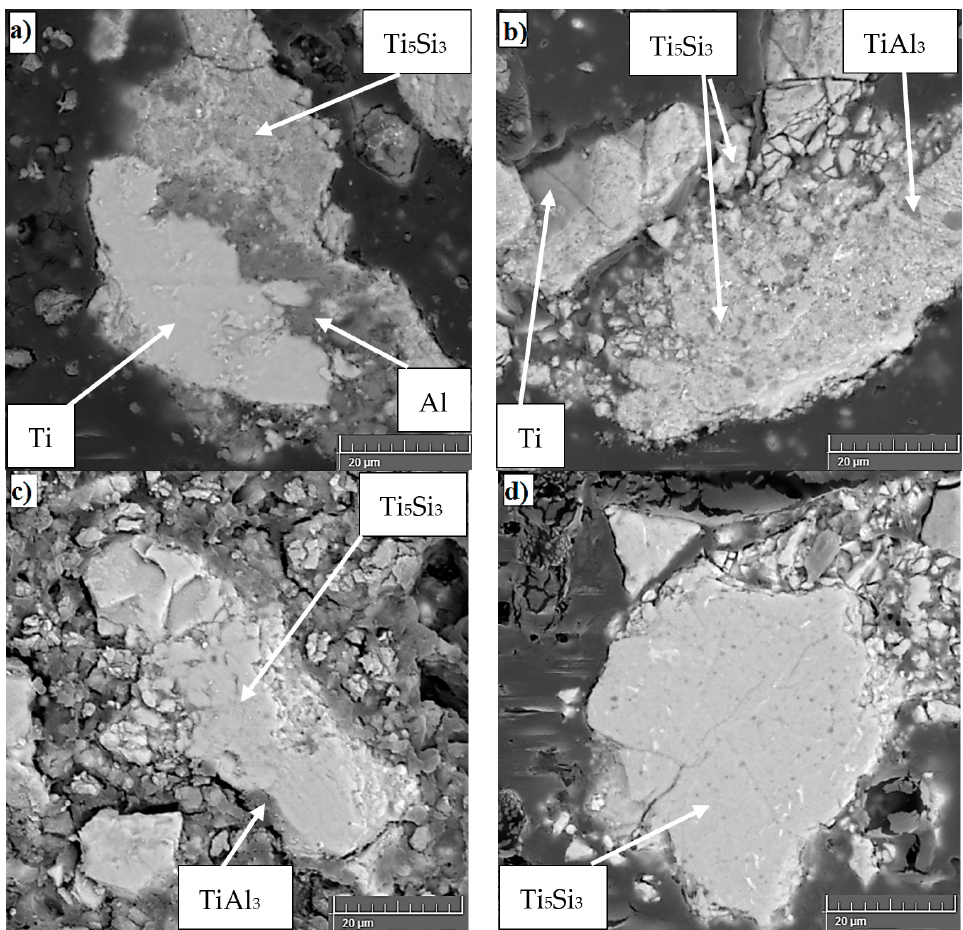
Figure 3. Microstructure of TiAl15Si15 alloy powders after MA: ( a ) 0.5 h, ( b ) 1 h, ( c ) 2 h, ( d ) 4